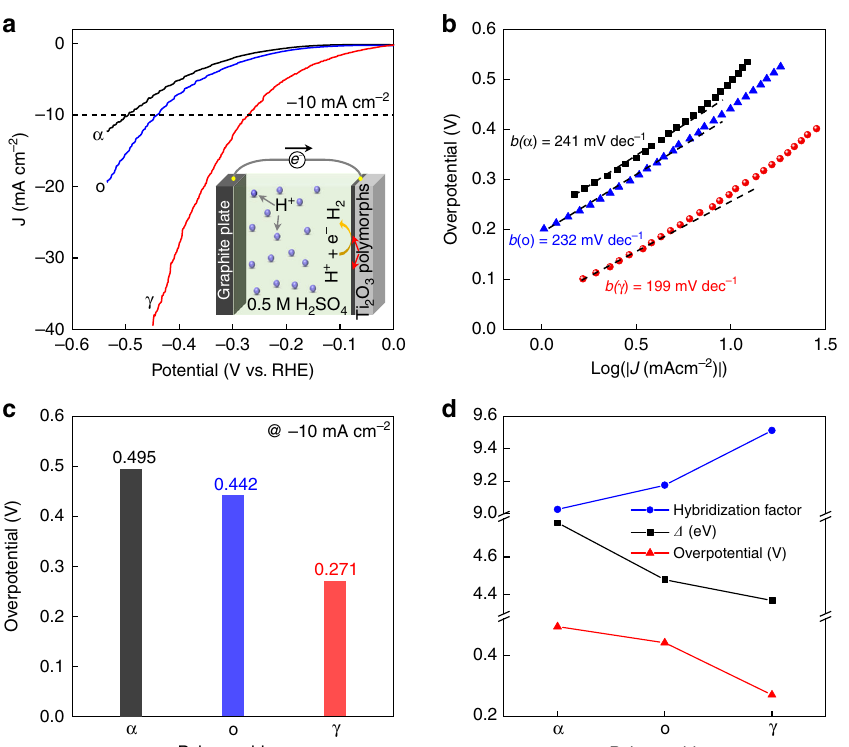
Fig. 6 Electrocatalytic hydrogen-evolution activities of Ti 2 O 3 polymorphs. a Linear sweep voltammetry (LSV) and ( b ) corresponding Tafel plots of the LSV curves for α -, o-, and γ -Ti 2 O 3 polymorphs (electrolyte: 0.5M H 2 SO 4 , scan rate: 5mVs − 1 ). c Overpotential of HER for Ti 2 O 3 polymorphs (@ − 10mAcm − 2 ), deduced from ( a ). d Correlations between the physical parameters and HER activity in Ti 2 O 3 polymorphs. Source data are provided as a Source Data fi